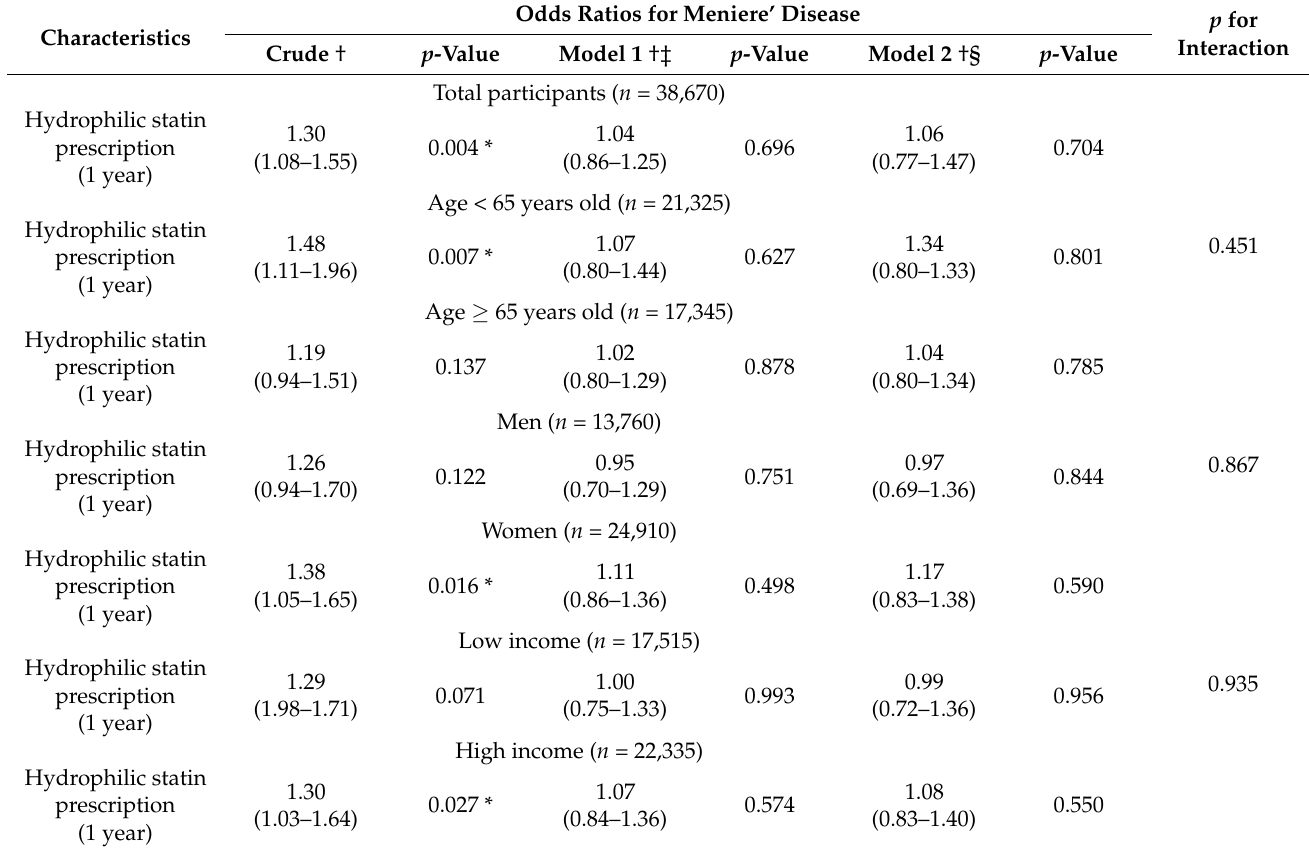
Table 4. Crude and adjusted odd ratios (95% confidence interval) of date of hydrophilic statin prescription (1 year) for Meniere’s disease with stratified subgroup according to age, sex, income, and region of residence. Odds Ratios for Meniere’ Disease p Characteristics